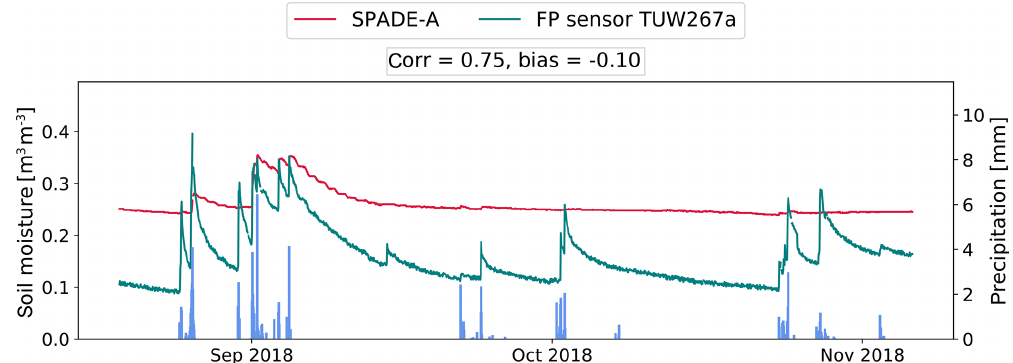
Figure A2. Soil moisture time series of FP sensor TUW267a and professional probe Hoal_13 at a depth of 0.05m, installed next to each other. While the low-cost sensor shows distinct peaks due to rain events, the professional probe reacts considerably weaker.